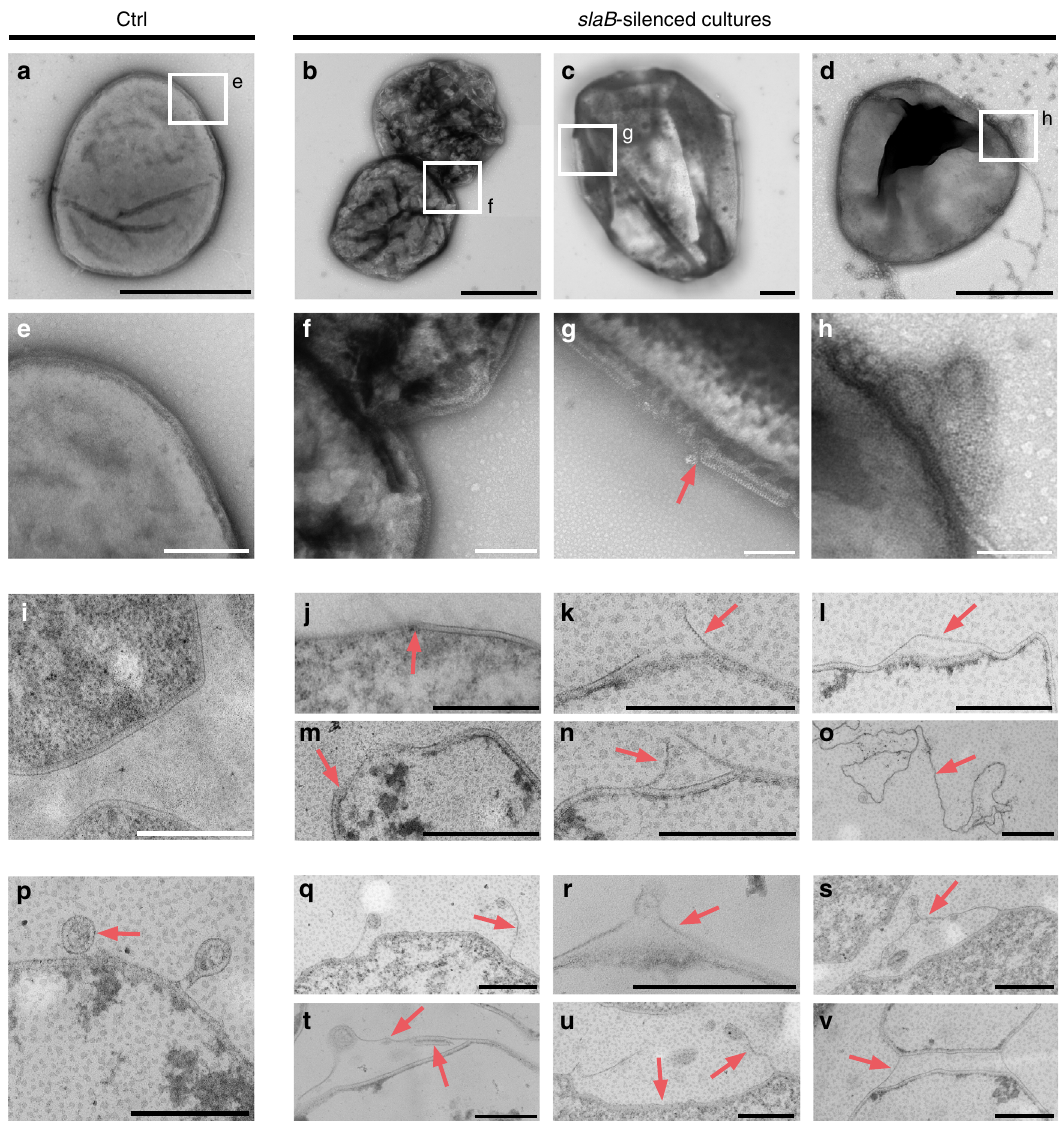
Fig. 3 Electron micrographs of silenced and control (Ctrl) cultures. All cultures (pIZ-transformants) were harvested at OD 600 = 0.1. a – h Transmission electron micrographs of negatively stained (2% Uranyl acetate) cells of Ctrl in a and SB3×6 cultures in b – d with indicated areas magni fi ed in e – h . Scale bars: a – d: 1 µ m; e-h: 200 nm. i – o Envelope morphologies of Ctrl in i and slaB -silenced SB3×6 and SB2 cultures in j – o visualized by transmission electron microscopy of thin sections (contrasted with Uranyl acetate 2% and Lead citrate 2%); Scale bar: 500 nm. p – v Vesicle secretion in Ctrl in p and slaB- silenced SB3×6 and SB2 cells in q – v visualized by transmission electron microscopy of thin sections (contrasted with Uranyl acetate 2% and Lead citrate 2%). Red arrows indicate S-layer. Scale bar: 500